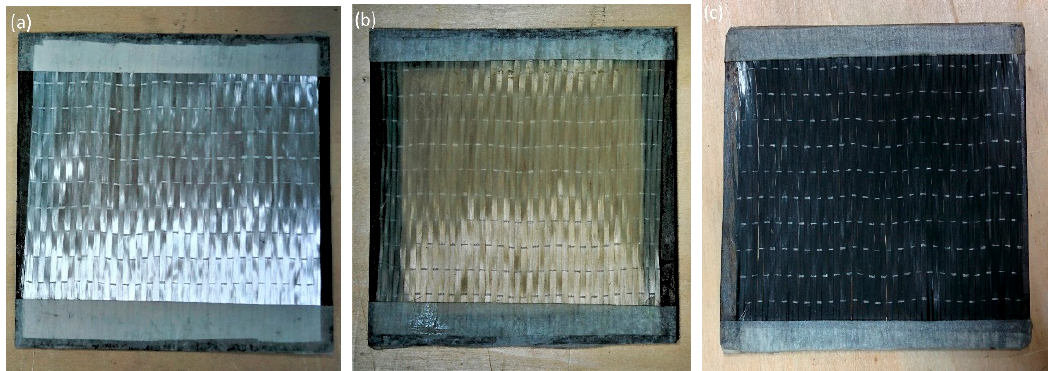
Figure 1. Representative images of glass fibers (GF) ( a ) as received, ( b ) after the EPD process, and ( c ) after chemical reduction.